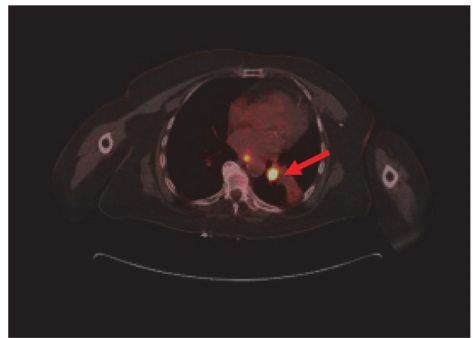
Figure 2. Nuclear Medicine Positron Emission Tomography / Computer Tomography (NM PET / CT): left lower lobe hypermetabolic neoplasm (red arrow) causing bronchial obstruction and distal collapse. Metastatic mediastinal adenopathy. Not shown, L3 vertebral body, left acetabulum pubis, and superior pubic ramus metastasis.